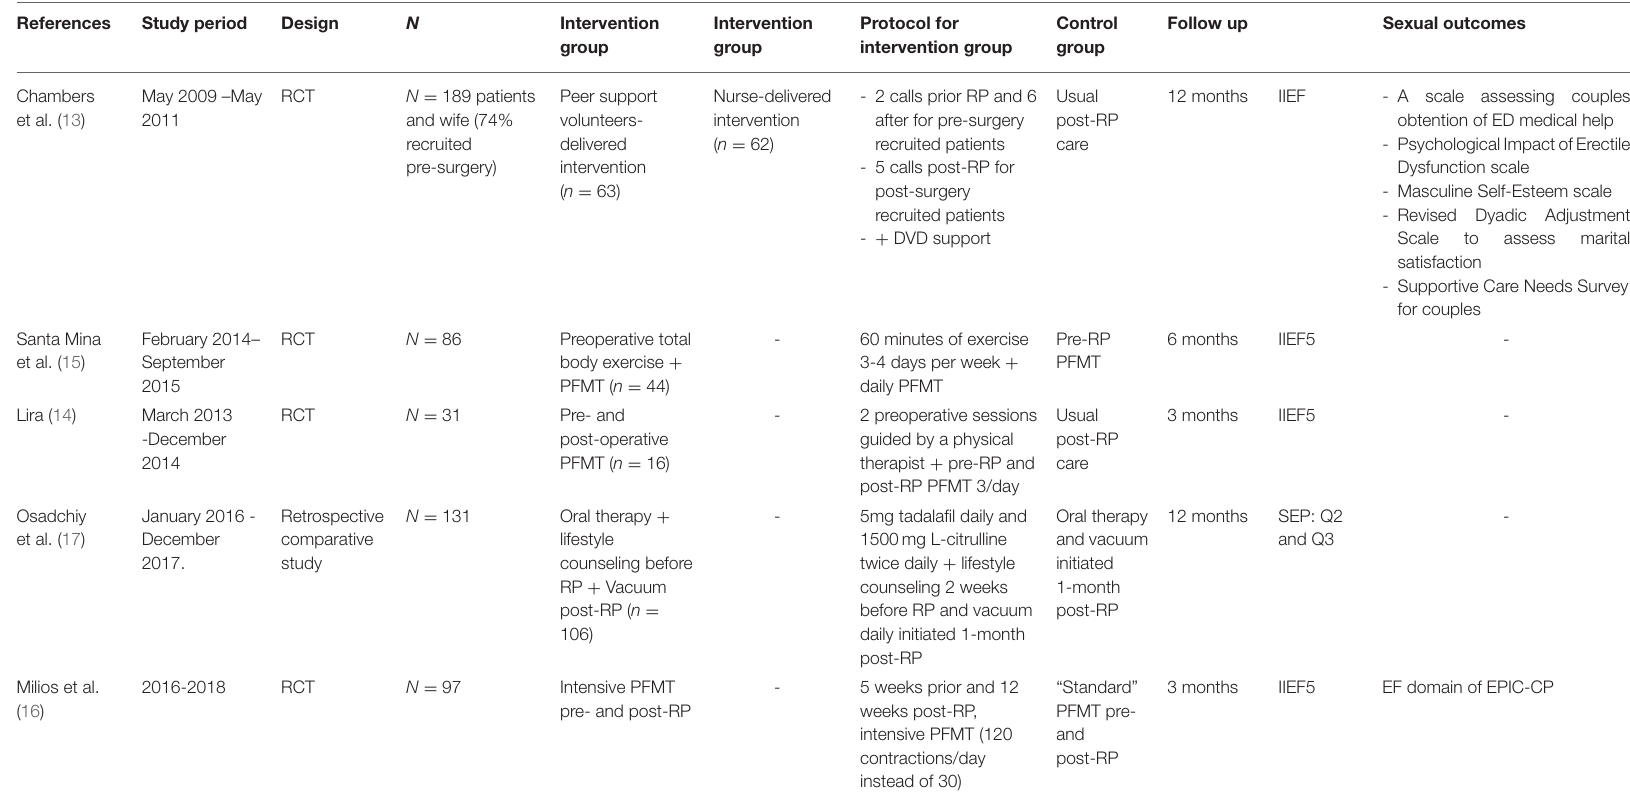
TABLE 1 | Summary of study